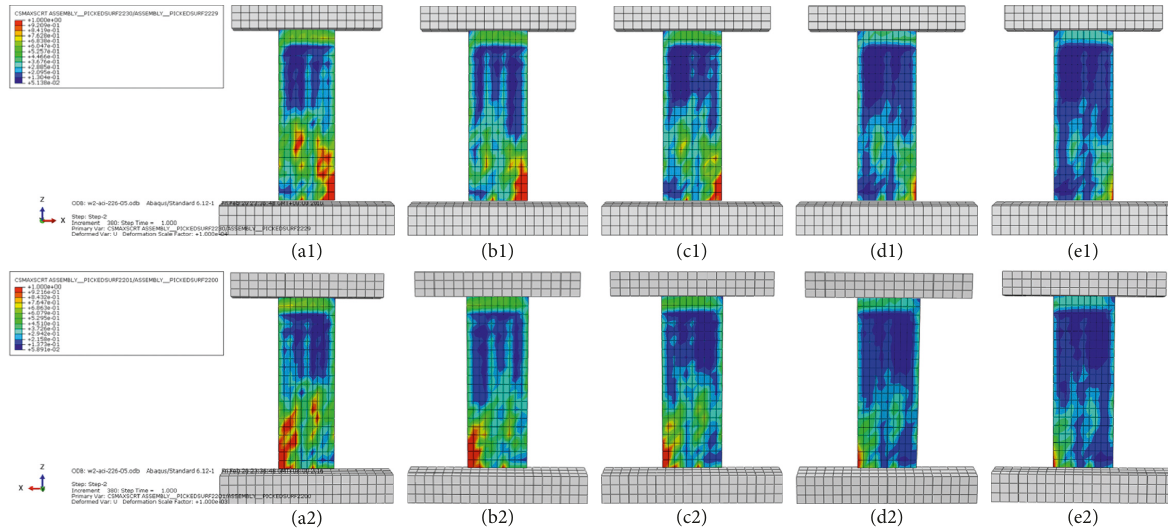
Figure 25: Maximum traction damage initiation criterion index CSMAXSCR of W2 under 0.5 axial compression ratio.